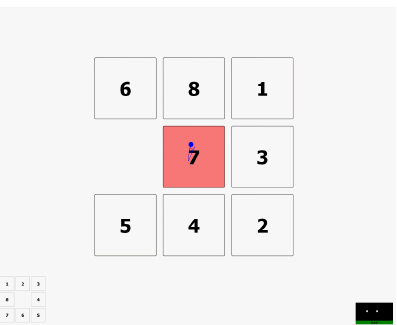
Figure 1 . 8-tile slide puzzle, after the tiles have been shuffled. User is gazing to the center and could see the target solution (bottom left) and the status of the eye-tracking (bottom right).